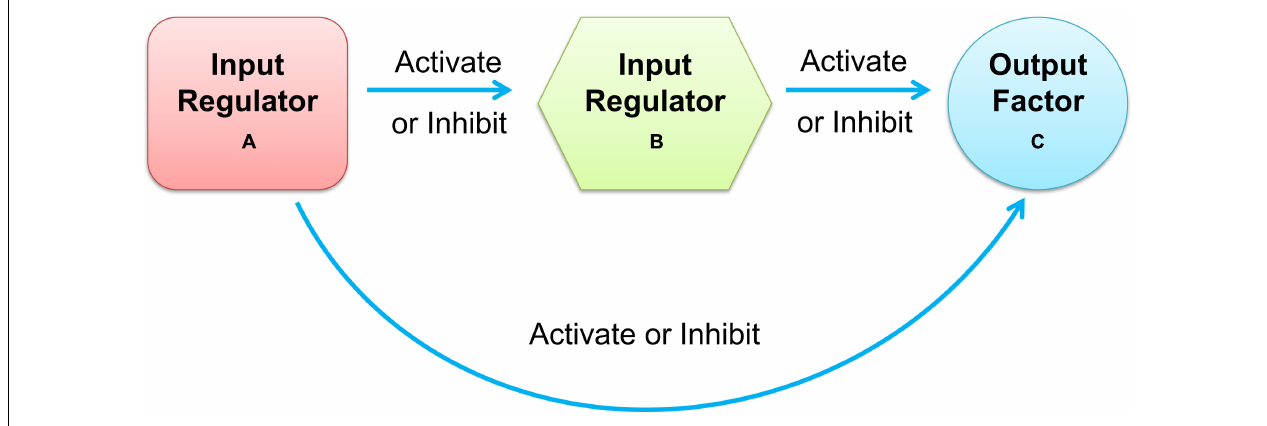
FIGURE 1 | Schematic diagram of feedforward